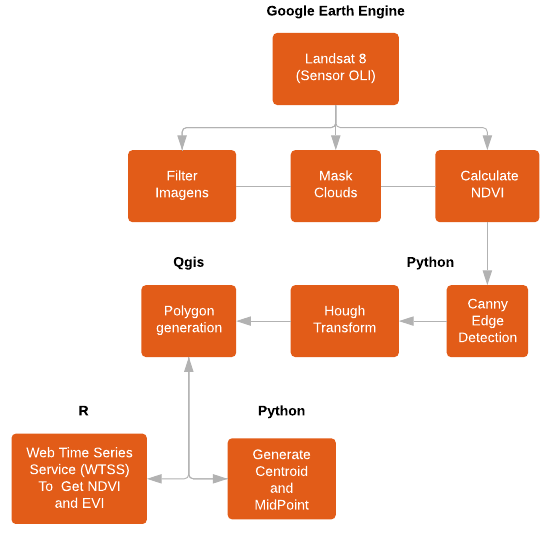
Figure 3. Flow chart of our approach.